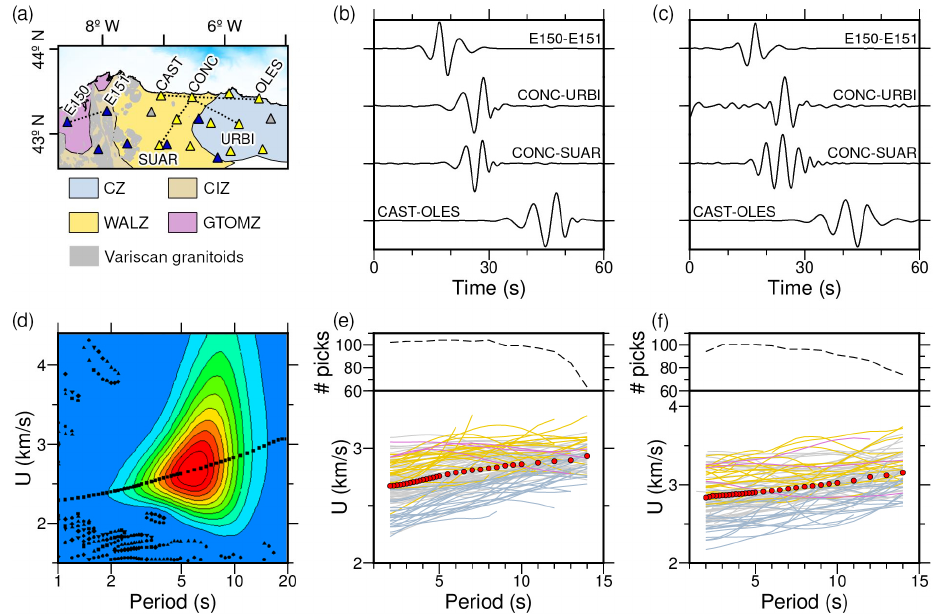
Figure 2. (a) Location of the displayed interstation paths over a simplified map of geological domains. Triangles represent the position of the seismic stations using color codes in Fig. 1. (b) Examples of stacked vertical and (c) transverse component symmetric EGFs. Rayleigh and Love waves are the dominant phases, respectively. (d) Example of MFA surface for the CONC-URBI (vertical component) station pair, showing the fundamental mode Rayleigh-wave group velocity dispersion curve. (e) Rayleigh- and (f) Love-wave group velocity dispersion curves showing the number of velocity estimations used in the inversion as a function of the period. Dispersion curves obtained for paths fully contained within the main geological domains are highlighted using the colors in Fig. 2a, except for paths crossing the CIZ, GTOMZ, or both, which are marked in pink. Grey dispersion curves represent mixed paths that span through more than one region. Red circles illustrate the average dispersion values used in the computation of the initial regional S-wave velocity models. U : group velocity.